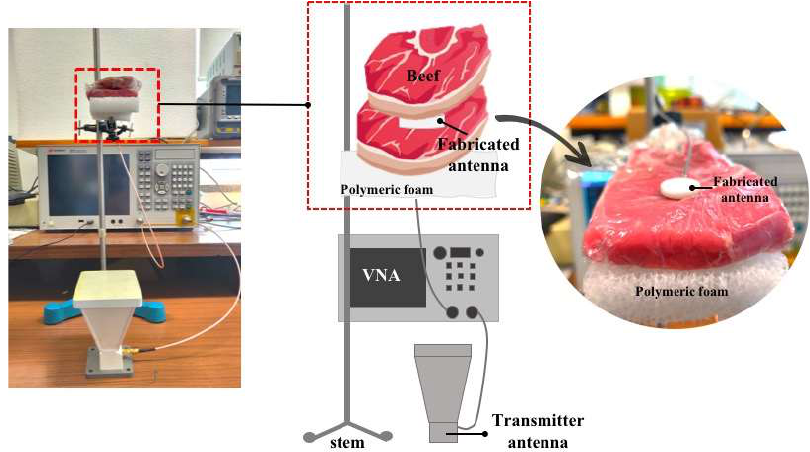
Figure 5. Schematic illustration of the antenna testing setup. The transmitter antenna is distanced 25 cm from the fabricated antenna, which is placed between two 1 cm-thick beef steaks to approximate the test conditions for human body implantation.